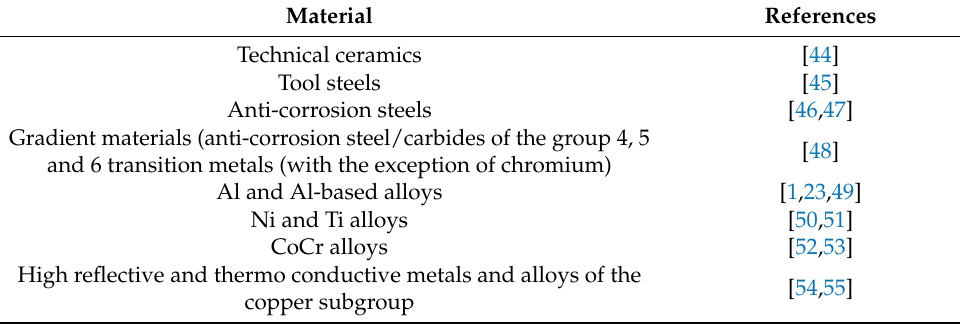
Table 1. The most spread engineering materials for